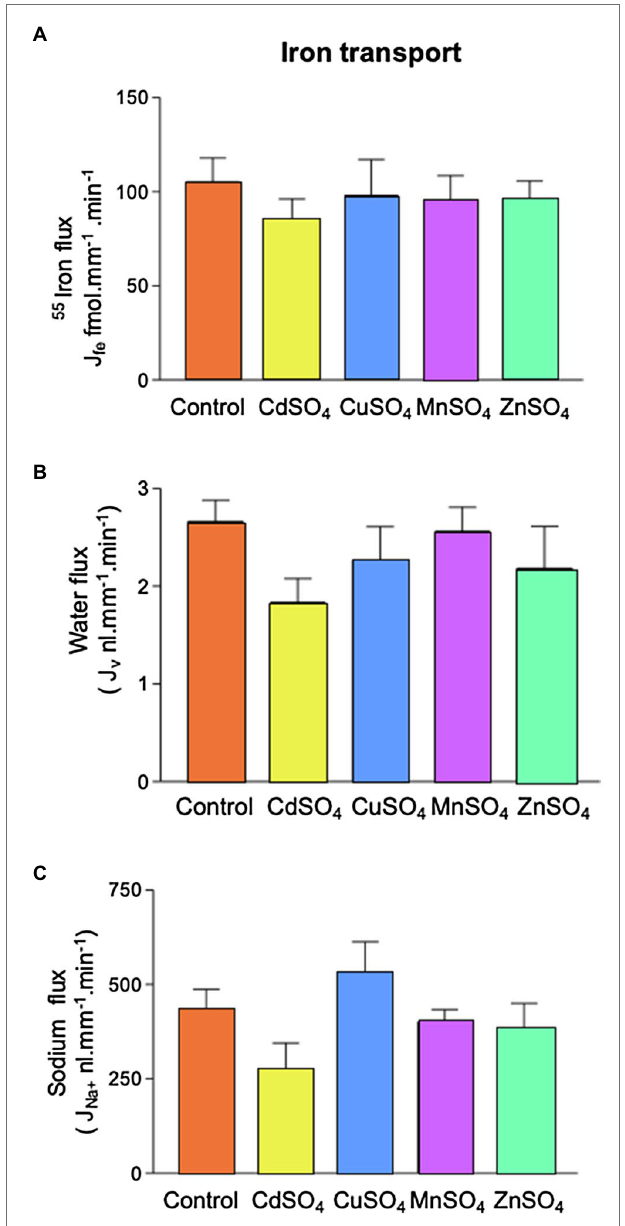
FIGURE 5 | Effect of competing divalent metal addition on 55 Fe, water and Na + flux in microperfused renal PCTs. Tubules were perfused with 12 μ mol.l − 1 55 FeCl 3 (control) and CdSO 4 , CuSO 4 , MnSO 4 , or ZnSO 4 were included (12 μ mol.l − 1 ). (A) 55 Fe flux was unaffected by competing metals. (B) Inclusion of competing metals had no statistically significant effect on water flux. (C) Inclusion of competing metals had no statistically significant effect on Na + flux. Number of replicates were as follows: control =19, CdSO 4 = 9, CuSO 4 = 9 MnSO 4 = 8, or ZnSO 4 =